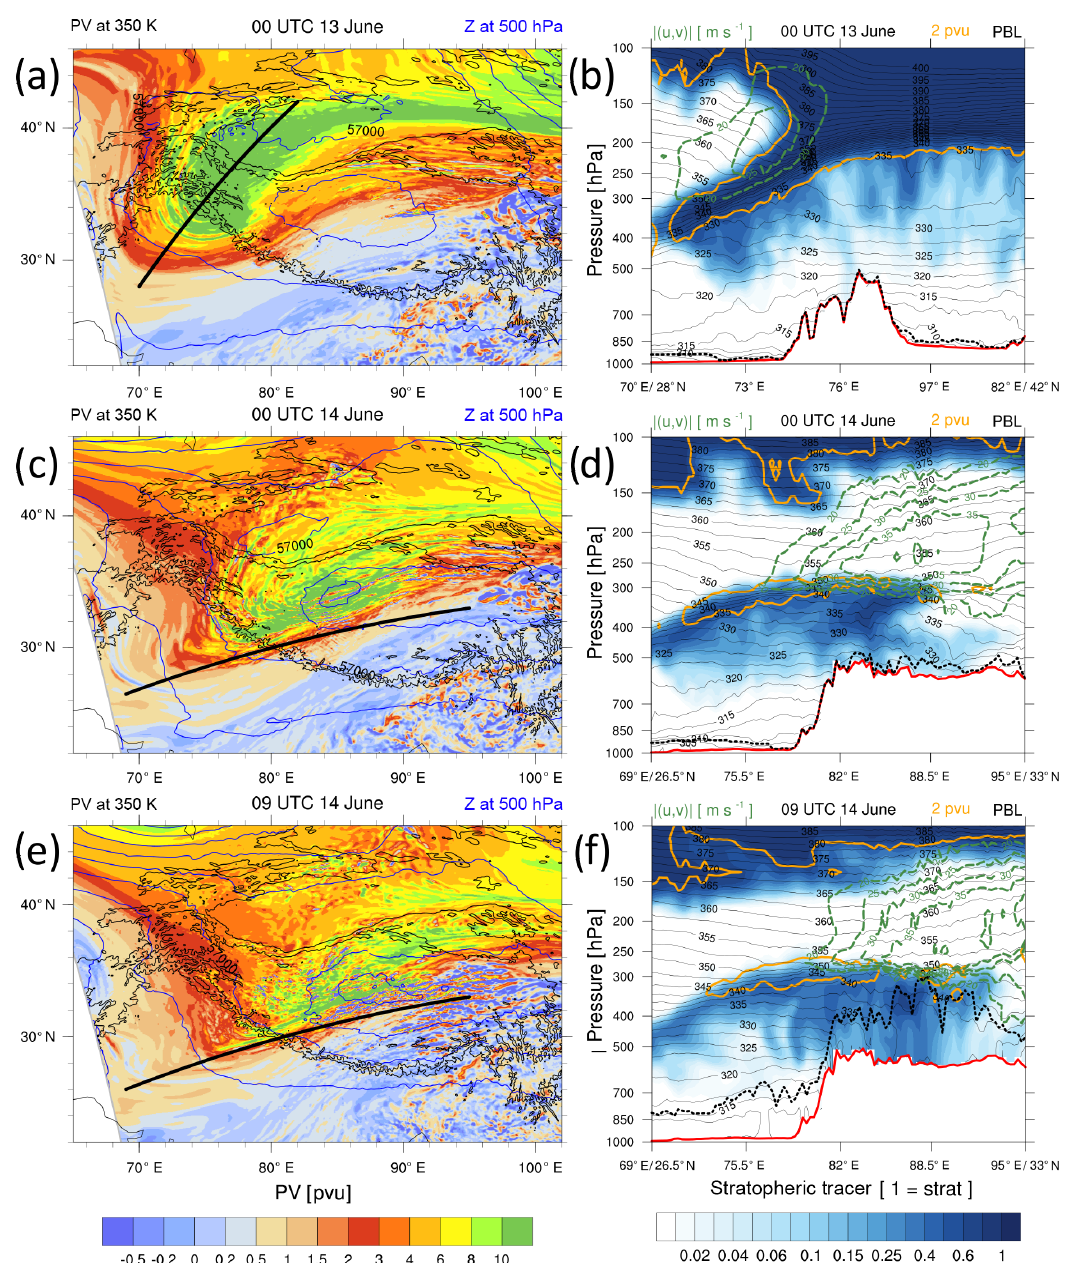
Figure 5. Left column: PV on 350K (in pvu, coloured) and geopotential height at 500hPa (blue contours, interval 250m) at (a) 00:00UTC on 13 June, (c) 00:00UTC on 14 June, (e) 09:00UTC on 14 June 2014. Right column: corresponding vertical sections across the tropopause fold, as indicated by the black lines in the left column. Shown are the concentration of stratospheric tracer (blue colours; a value of 1 denotes purely stratospheric air, note the non-linear scale), horizontal wind speed (in ms − 1 , dashed green contours), 2pvu isoline (orange contour), isentropes (in K, thin black contours), PBL height (dashed black contour) and topography (thick red